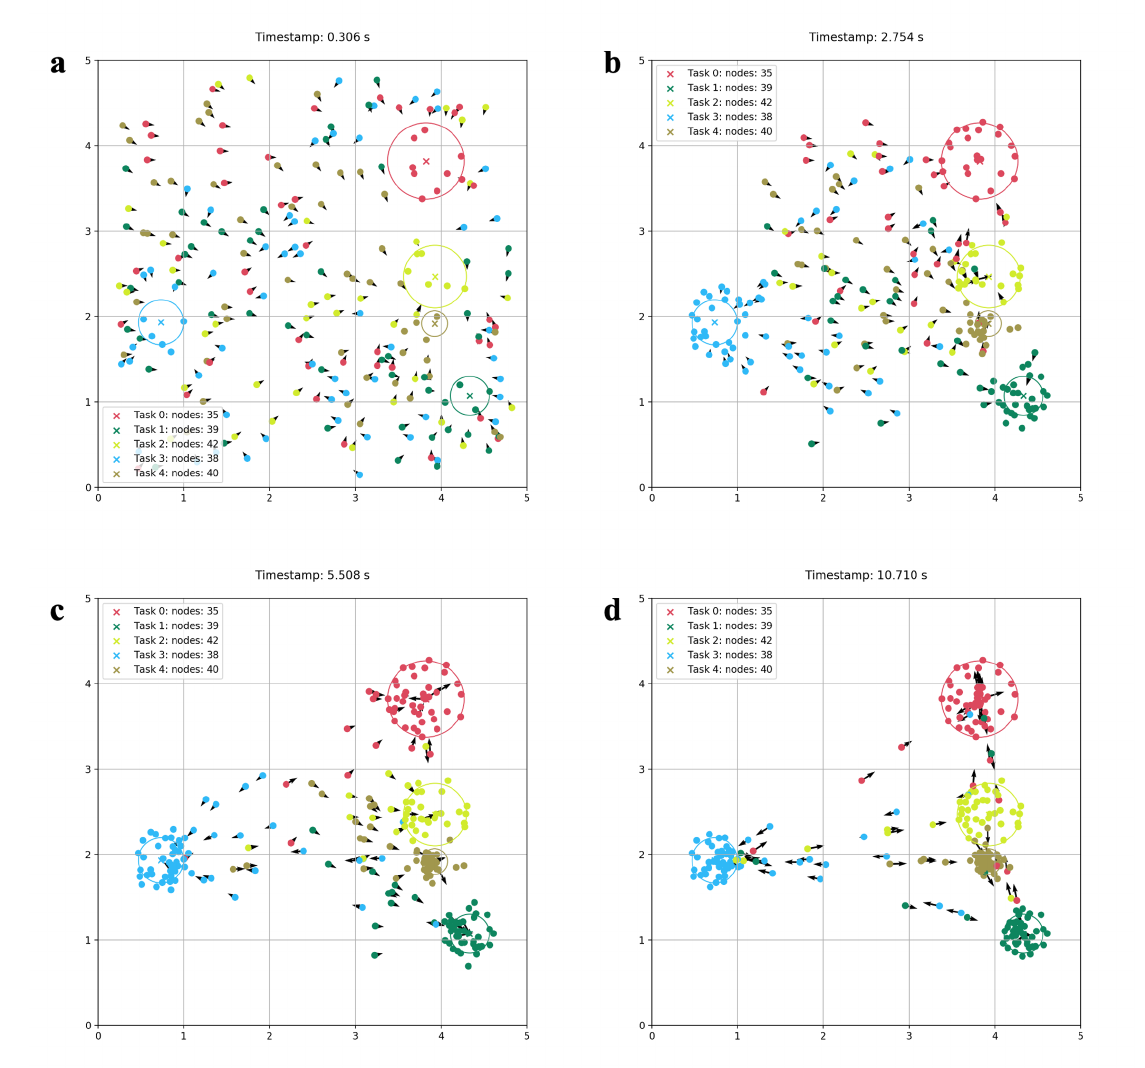
Figure 7. Illustration of a procession in time ( a – d ) of a simulation with 5 randomly placed tasks, with random radii, in a 5 × 5 unit field, where 250 nodes are placed at time 0 at random locations. Each task is associated with a random color seen in the legend. The color of each node represents its target task. The small black arrow of each node indicates the direction and magnitude of the velocity of said node. In the legend “Task 0: nodes: 9” represents a task with ID 0 and expected 9 nodes to aggregate. The parameters used to run the simulation were (cid:126) θ LRmin seen in (24) and obtained by minimizing the hypercurve obtained by Linear Multivariable Polynomial